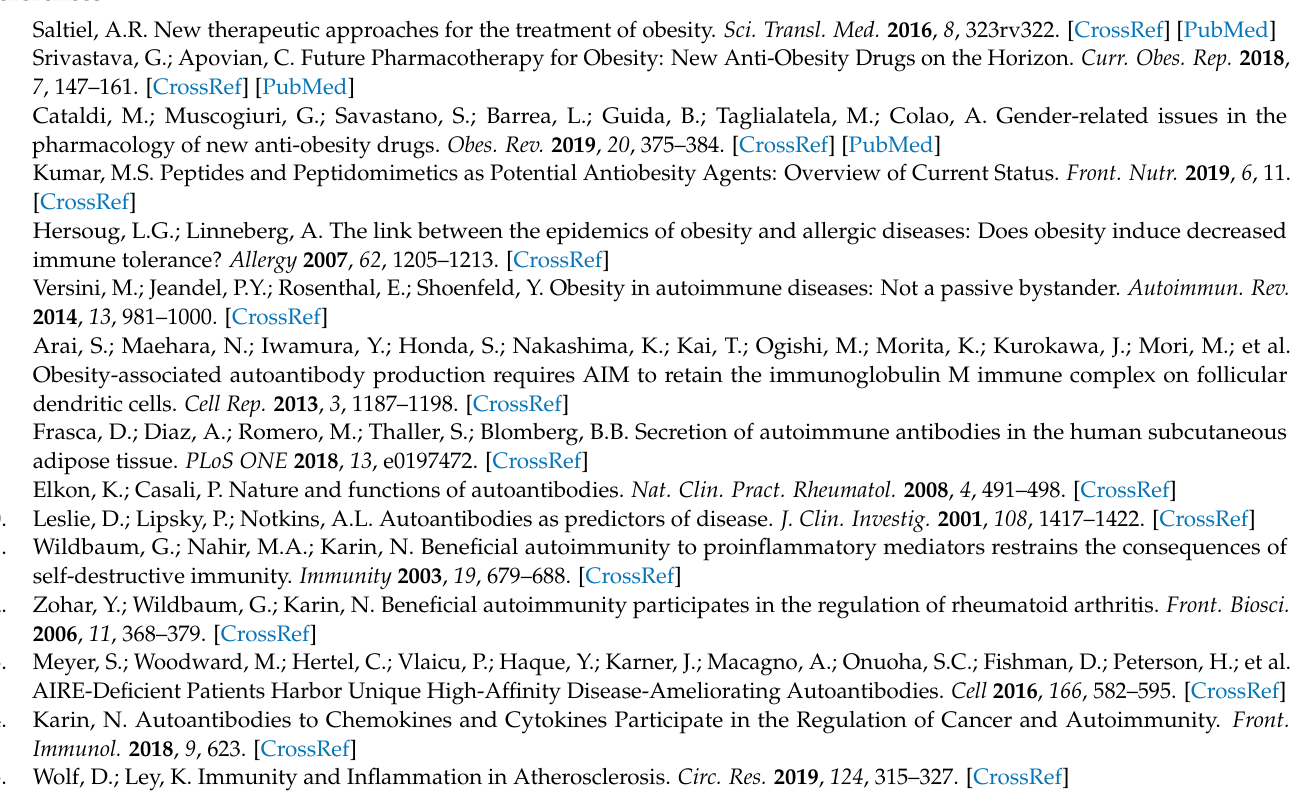
in mouse and human, Supplementary Figure S2: Establishing criteria for true autoantibody positivity, Supplementary Figure S3: Pattern of autoantibody extinction along obesity